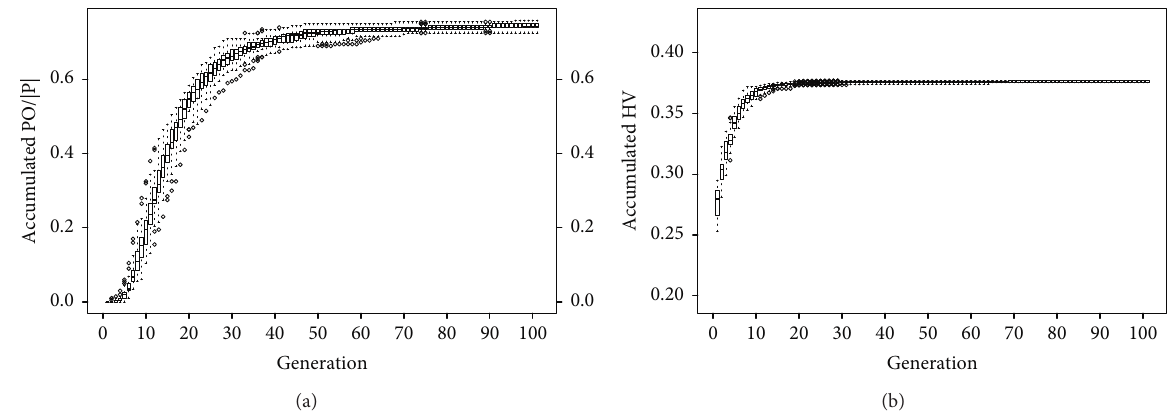
Figure 3: Accumulated number of Pareto optimal solutions and hypervolume of the accumulated joint nondominated sets. Algorithm